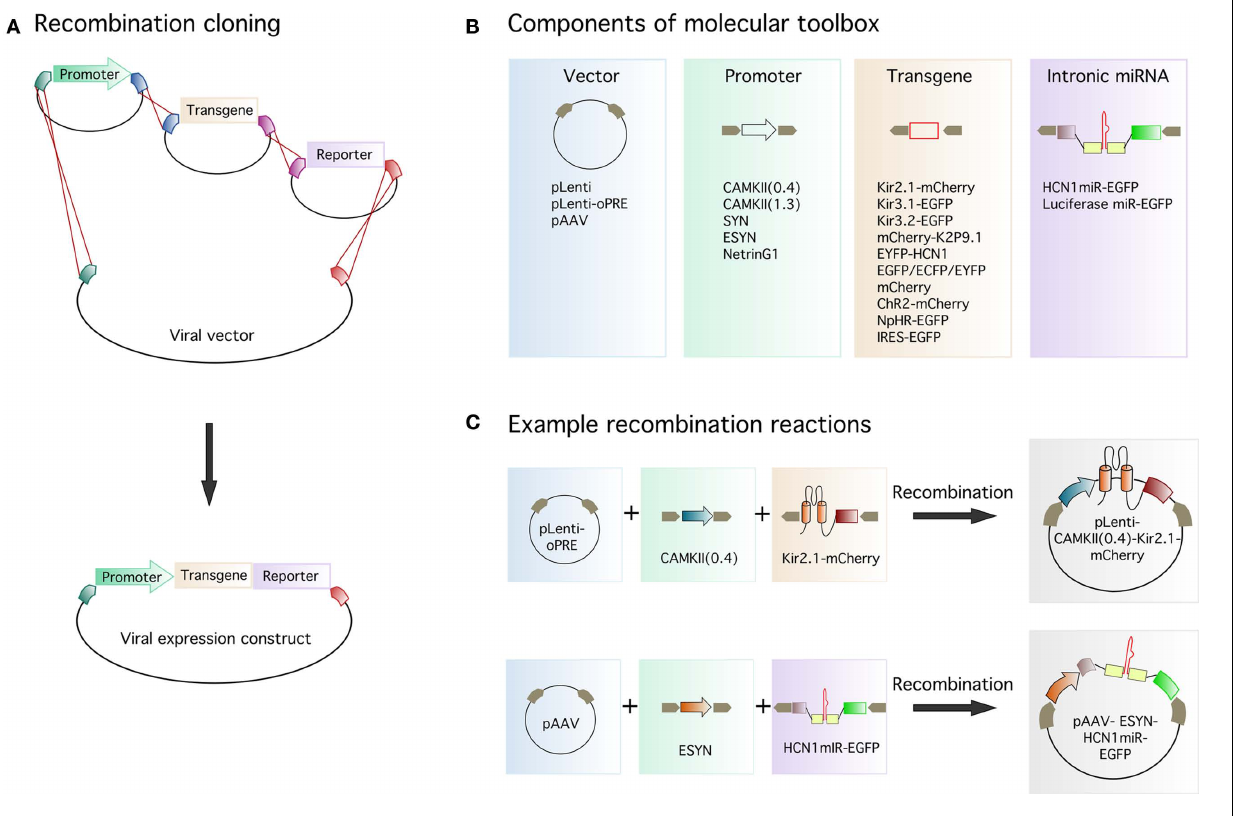
molecular toolbox flanked with att sites ready for recombination. For simplicity, only the att-flanked regions of the entry vectors are illustrated in (B,C) . (C) Examples of recombination reactions to generate the lentiviral expression construct plenti-CAMKII(0.4)-Kir2.1-mCherry and the AAV expression construct